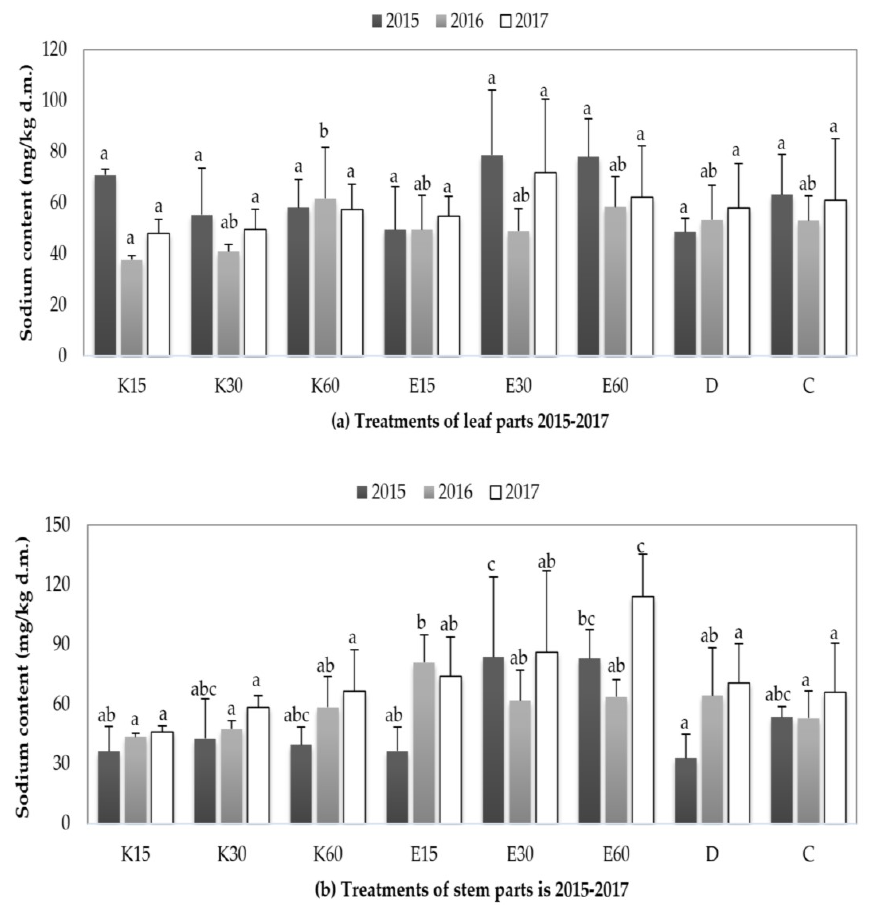
Figure 5. Sodium content values of leaf and stem parts from 2015 to 2017 growing years: ( a ) sodium content values of leaf parts in a year of 2015–2017; ( b ) sodium content values of stem parts in a year of 2015–2017. The year of 2015 average sodium content data are presented from eight treatments. Results are means ± SD, n = 3. The letters introduce significant differences among irrigation water qualities for the three vegetation season, confirming to the Tukey’s test at p ≤ 0.1. The year of 2016 and 2017 average sodium content data are presented from six samples per treatment. Results are means ± SD, n = 6. Different letters introduce significant differences among irrigation water qualities for the three vegetation season, confirming to the Games-Howell’s test at p ≤ 0.05.